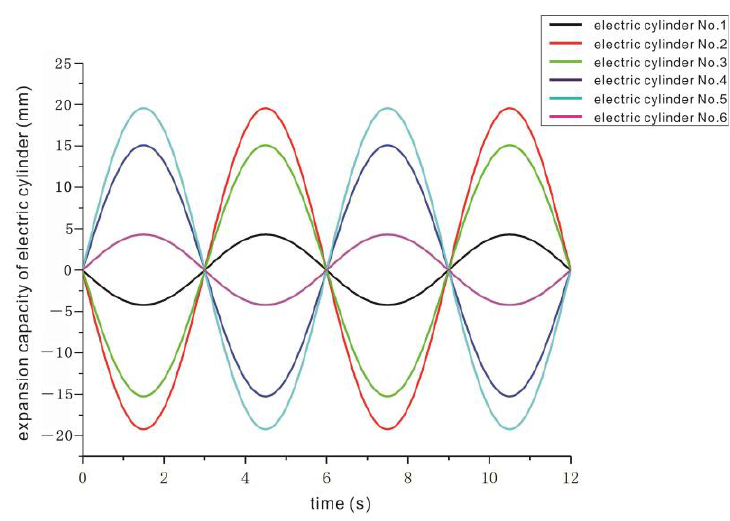
Figure 4. Simulation results of telescopic capacity of electric